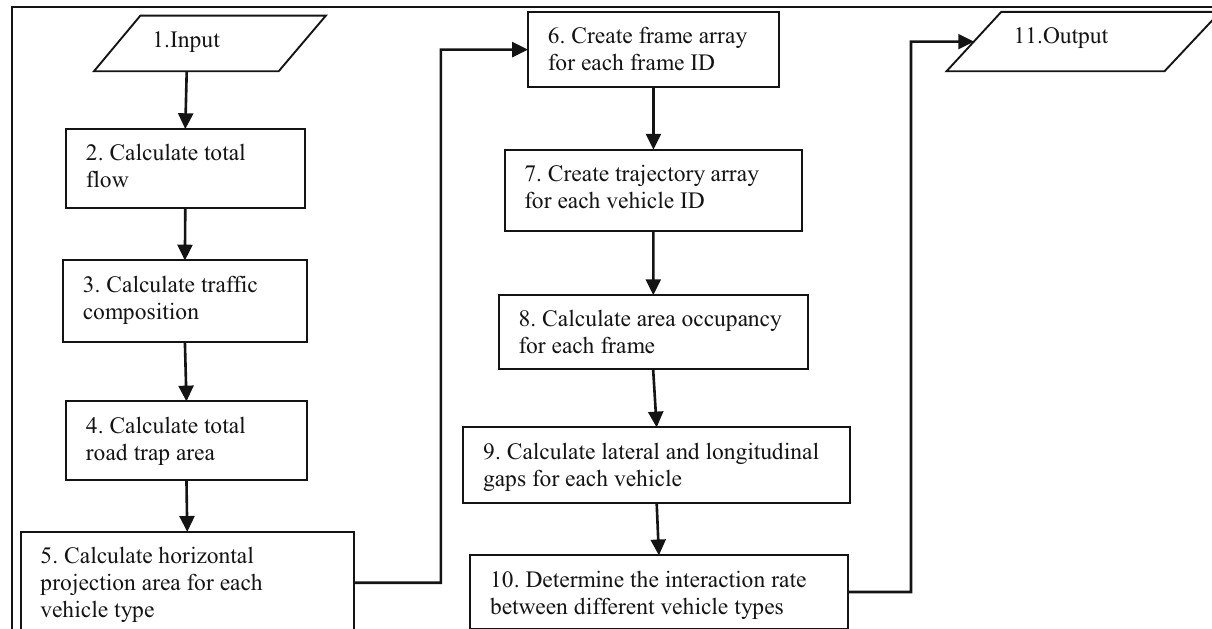
Fig. 6 Flow chart showing traffic flow characteristics extraction